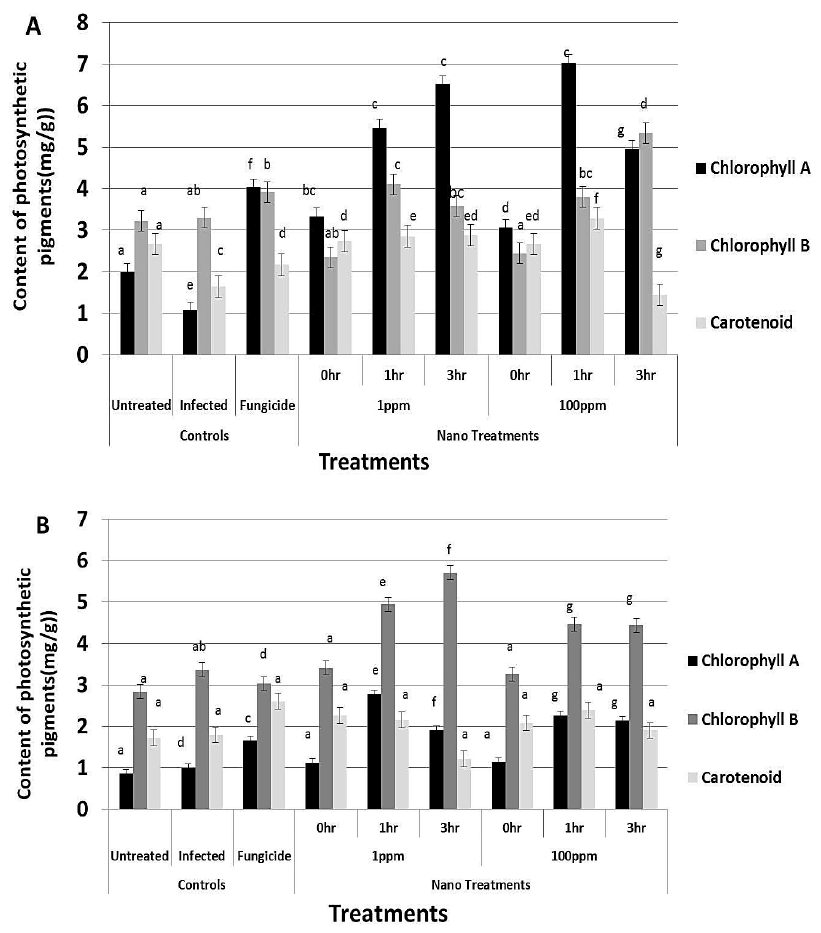
Figure 11. Effect of rGO-CuO NP treatments, as indicated, on dry weight of tomato and pepper plants (nine biological replicates). Two independent experiments with pepper plants are plotted. Letters on bars mean statistically significant differences between the mean of the respective control and the nanocomposite at the same concentration ( p ˂ 0.05).